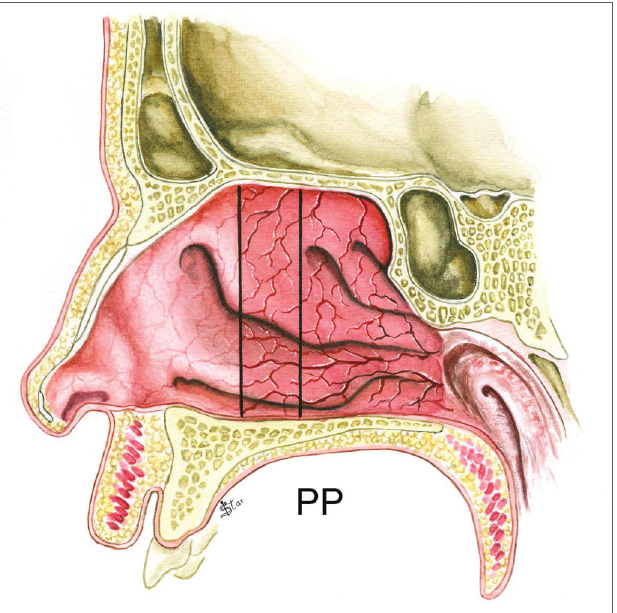
Figura 6. Estadiamento da PN no plano ântero-posterior - PP - pólipos com extensão posterior ao meato